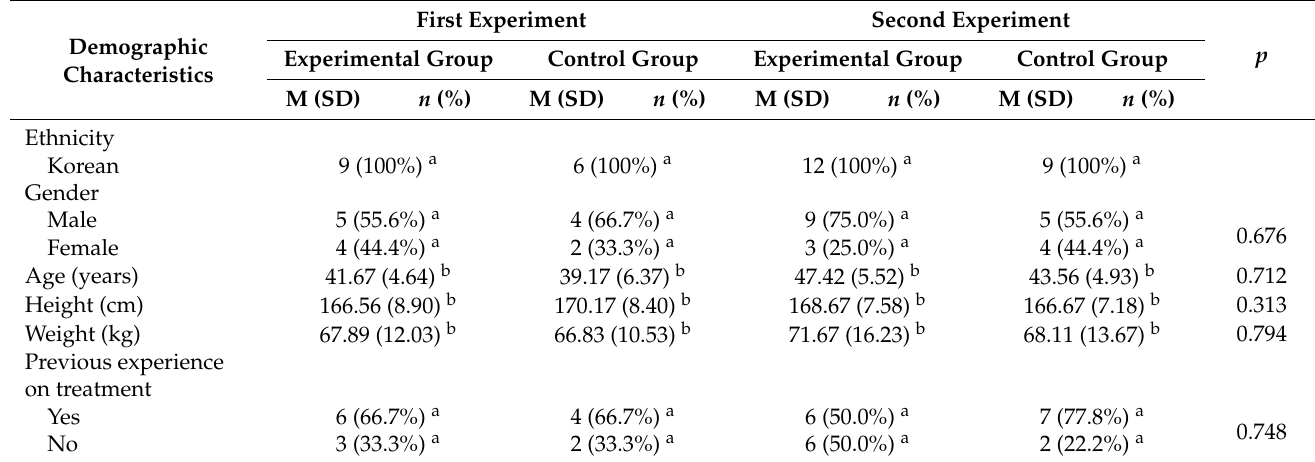
Table 2. Demographic characteristics of the experimental and control groups.